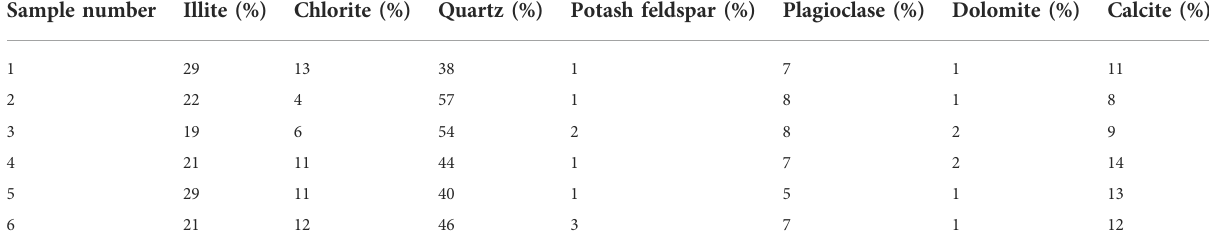
TABLE 4 Percentage of material composition derived from XRD